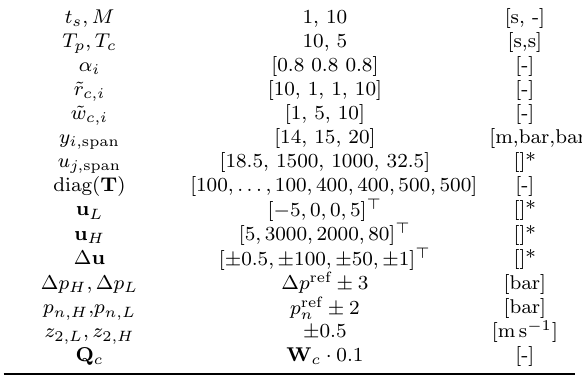
Table 8: Case 4 parameters. *[m, L / min, L / min,